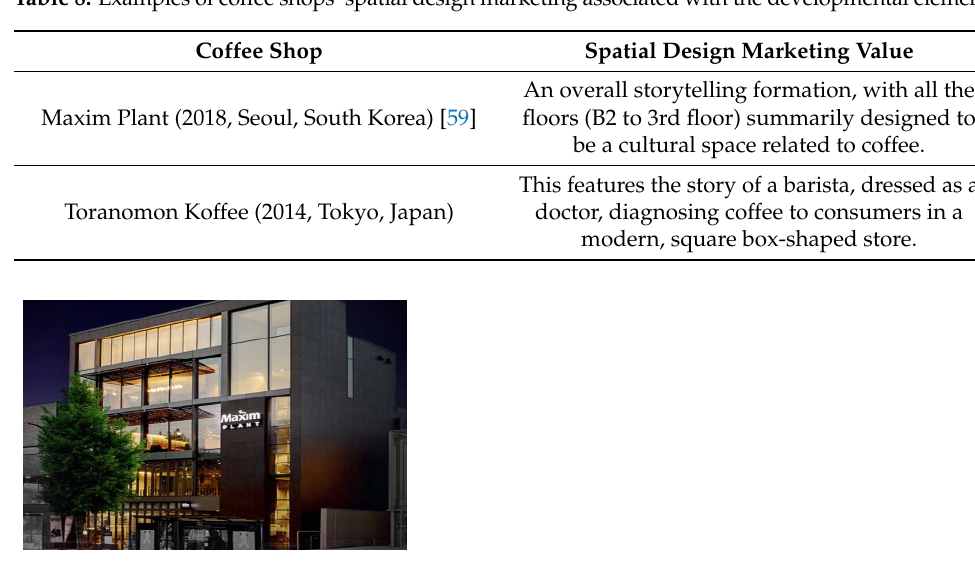
Figure 10. Café Slow (2001, Tokyo, Japan). Figure 10. Caf é Slow (2001, Tokyo, Japan).